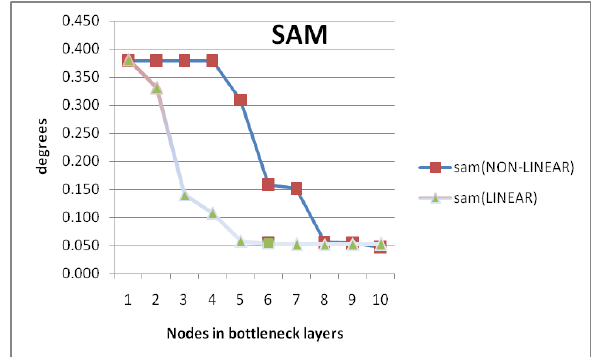
Figure 4. Spectral distortion in terms of SAM Therefore, best trade-off between the SNR and spectral